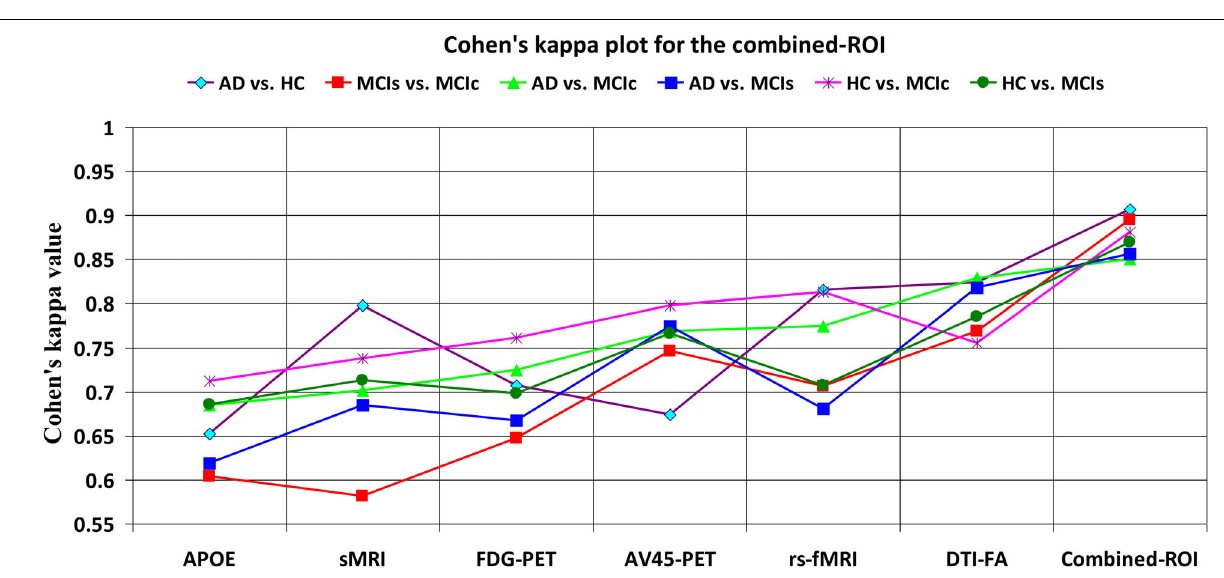
vs. HC and HC vs. MCIs). The obtained result